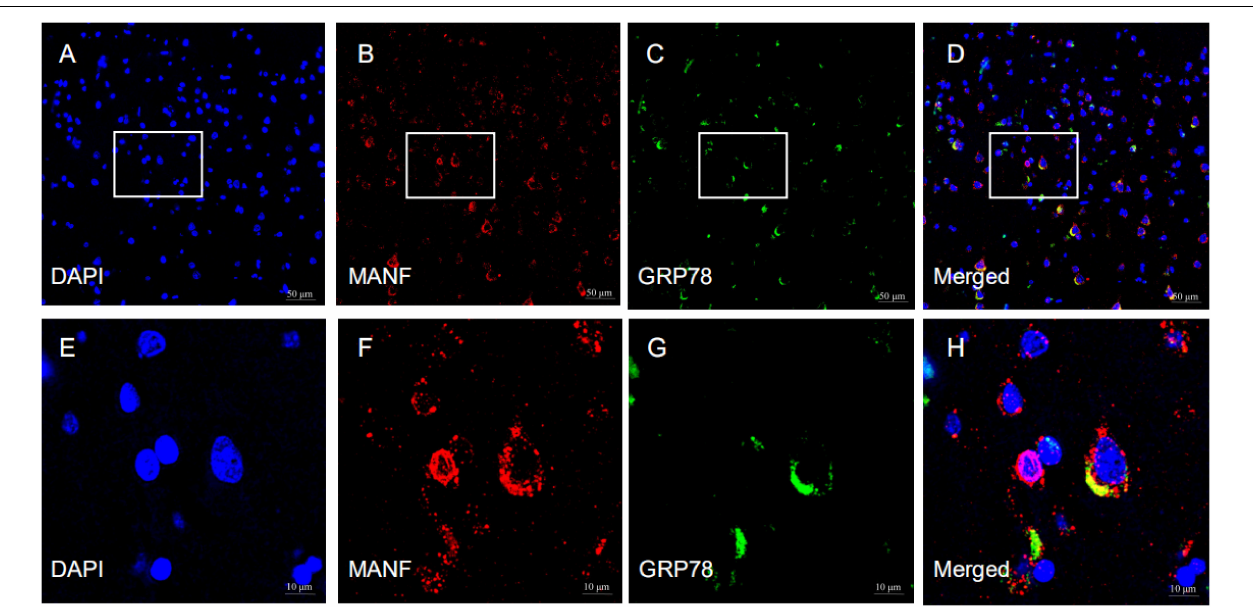
FIGURE 5 | Representative images of the expression of MANF and GRP78 in the ITGC. (A–H) The pictures above are representative images of immunofluorescence labeling for MANF (red) and GRP78 (green). The nuclei were stained with DAPI (blue). Picture D is a merged image of panels (A–C) . The magnified images show the expression and cellular distribution of MANF and GRP78, respectively. Scale bar: 50 µ m (A–D) and 10 µ m (E–H) .